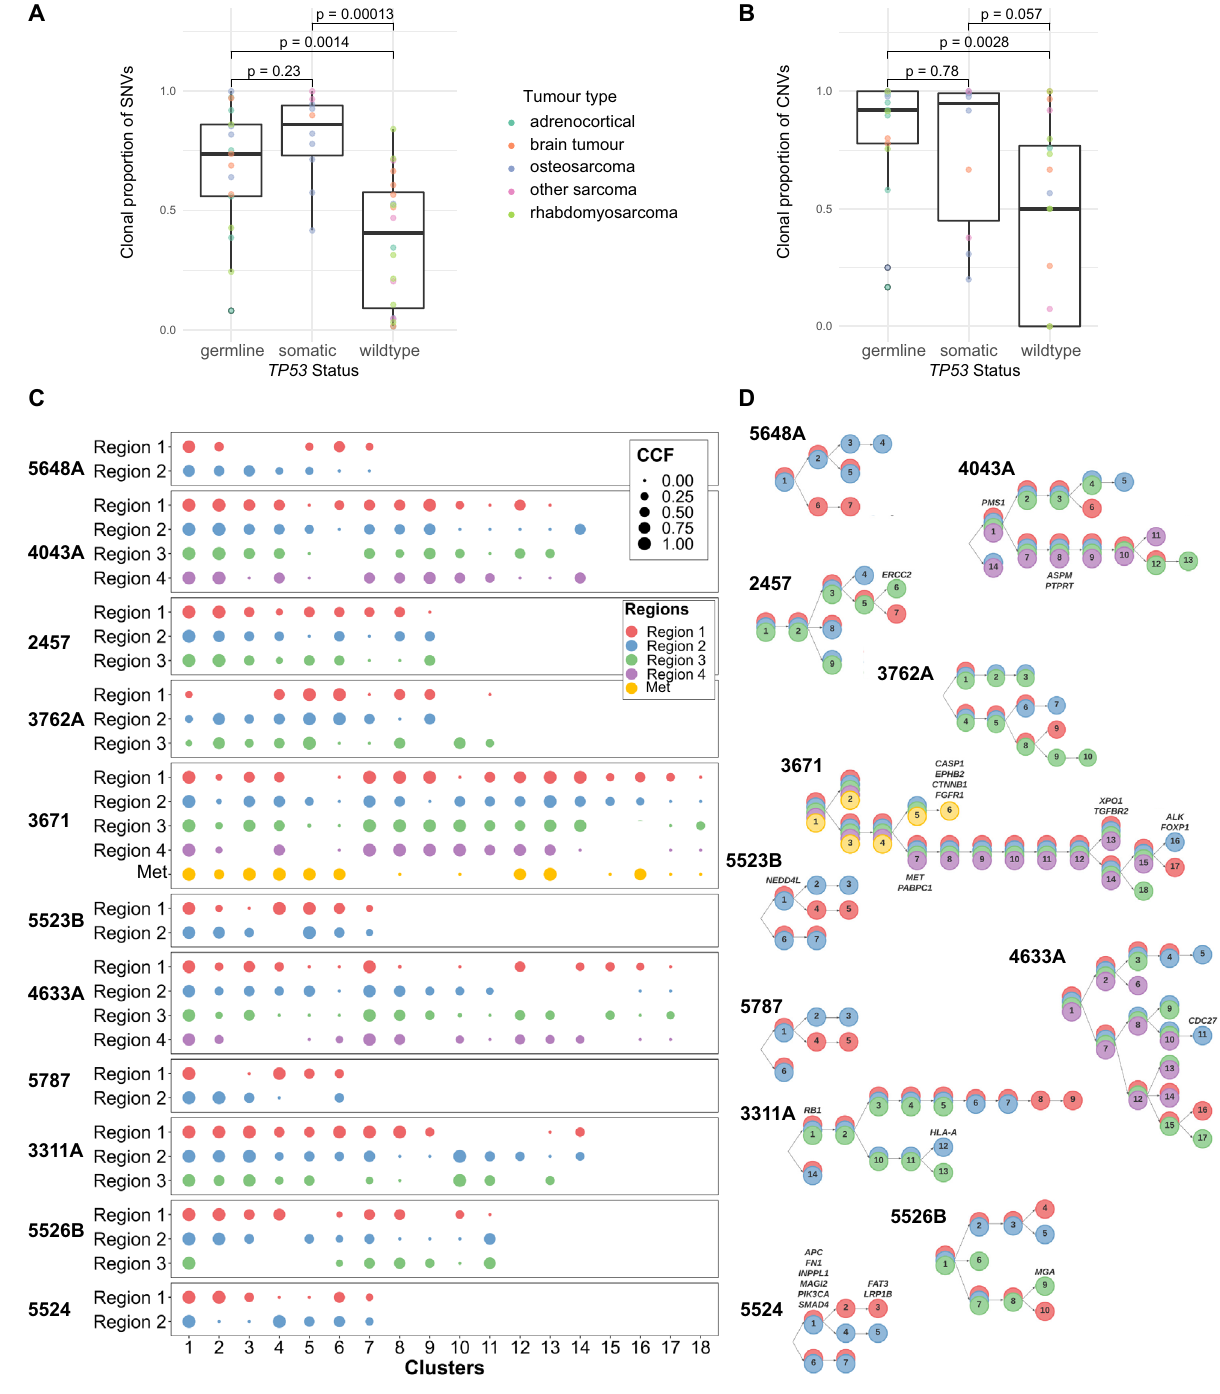
Fig. 5 | TP53 mutant tumors have high proportion of clonal mutations. A Boxplots showing proportion of SNVs per tumor (colored circles), which are clonal. Wilcoxon 2-tailed p -value shown. Colors indicate tumor type. Boxplots show quartiles with whiskers representing 1.5x interquartile range. N =47 biologi- callyindependentsamplesfromdistinctpatients. X -axisdepicts TP53 status, Y -axis depicts proportion of SNVs which are clonal. B Boxplots showing proportion of CNVs per tumor (colored circles), which are clonal. Wilcoxon 2-tailed p -value shown. Boxplots show quartiles with whiskers representing 1.5x interquartile range. Colors indicate tumor type. -axis depicts TP53 status, Y -axis depicts